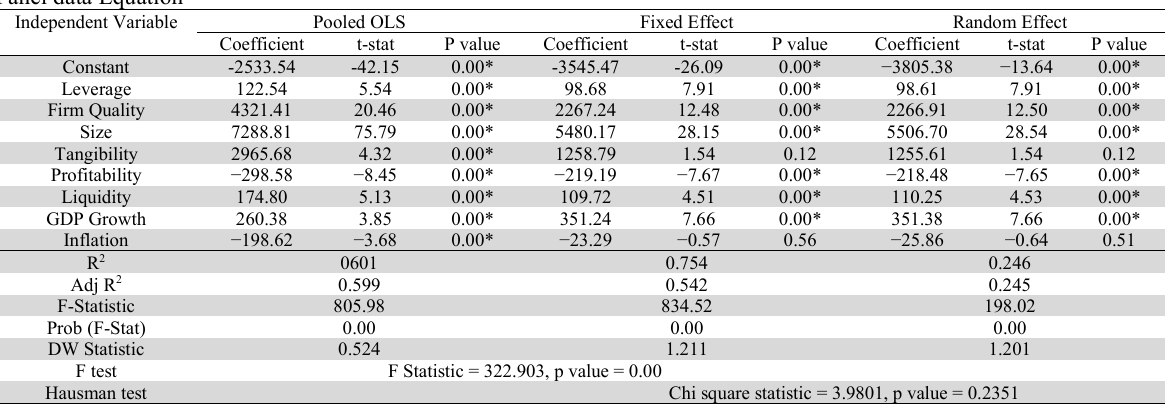
Panel data Equation Independent